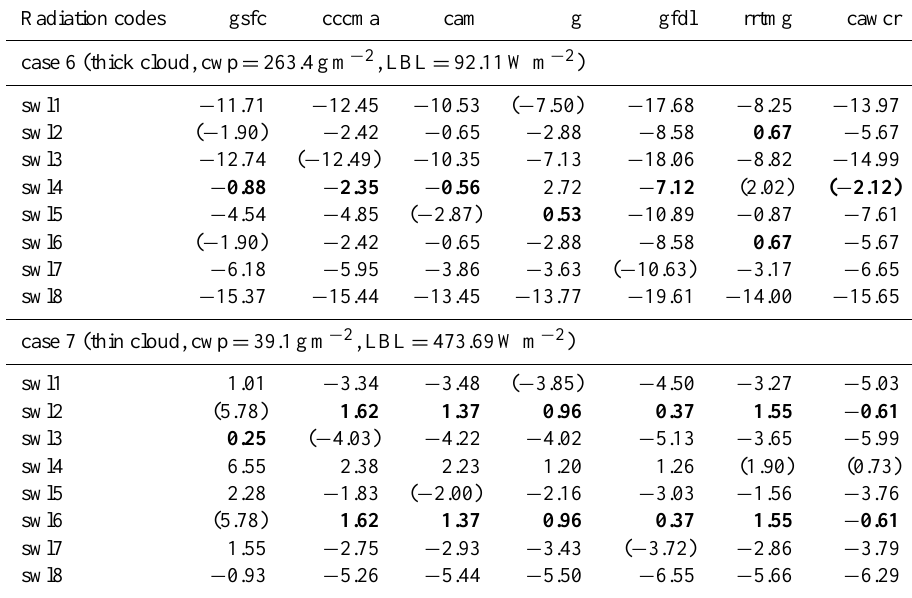
Table 4. Percentage differences of SWDNS from LBL reference calculations (LBLRTM for LW and CHARTS for SW) among CAR’s major radiation schemes by eight cloud optical property schemes for CIRC Phase I case 6 and 7. For each radiation scheme, the smallest error among all cloud schemes is in bold, while the result from the original combination is in